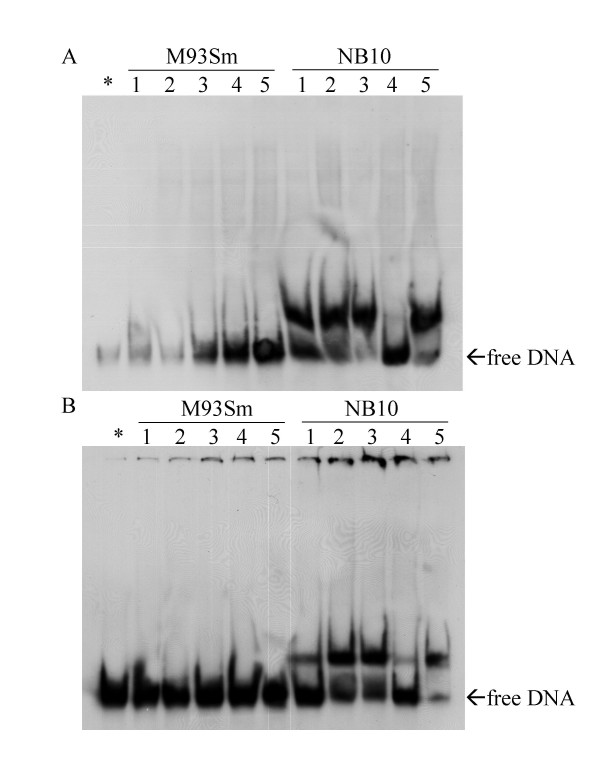
Gel shift analysis using a DIG-labeled 50 bp oligomer (0.8 ng/lane) containing the empA promoter region and putative lux box. Protein extracts were prepared from V. anguillarum M93Sm (left) and NB10 (right) incubated in (A) LB20 or (B) NSSM and added to DIG-labeled DNA. DIG-labeled DNA alone was added to the lane marked with an asterisk (*). Lane 1, 5 μg of protein extract from cells at time 0 h; lane 2, 5 μg protein extract from cells at time 3 h; lane 3, 7.5 μg protein extract from cells at time 3 h; lane 4, 5 μg protein extract from cells at time 3 h plus the unlabeled lux box-empA promoter containing oligomer; and lane 5, 5 μg protein extract from cells at time 3 h plus non-competitive oct2A (from E. coli) unlabeled 39 bp oligomer. The data presented are representative of three replicate experiments.